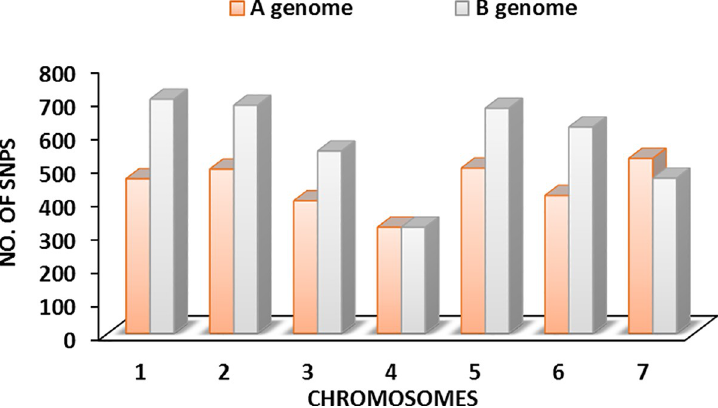
Fig 4. Chromosomal distribution of 7093 SNPs across genome A and B. They are a subset of the 8797 SNPs (Table 4) and are selected based on their MAF values of > 5% for all subsequent analysis. https://doi.org/10.1371/journal.pone.0243675.g004 marker AX-94856684 (on chromosome 2B) attaining the lowest value while AX-95238778 and AX-95096041(on chromosome 1B) having the highest value. Variation of phenotypic values of resistant and susceptible alleles was also assessed with Two-Sample T-test (assuming equal variances). This resulted in a highly significant difference between the resistant and susceptible allele carrying individuals (Table 7).